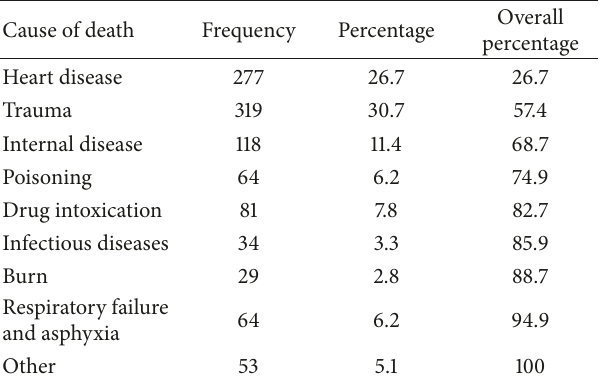
Table 3: Frequency distribution of the cause of death in the studied